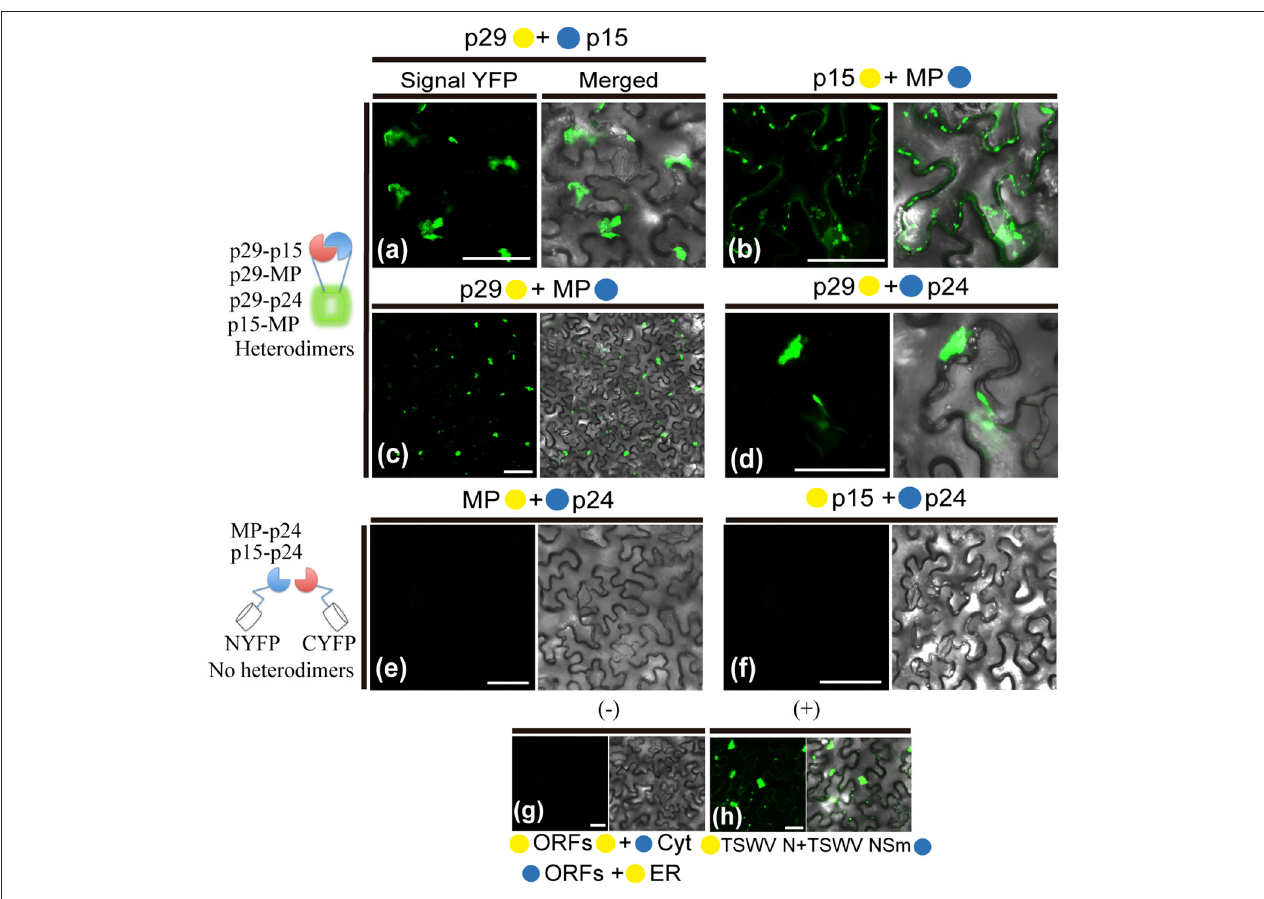
FIGURE 8 | BiFC analyses of heterodimerization between proteins of Citrus leprosis virus C. p29, p15, MP, and p24 carrying N-terminal (•) or C-terminal (•) YFP fragments fused at their N- ( •/•–ORFs) or C-termini (ORFs-•/•) were transiently co-expressed in N. benthamiana leaves by agroinfiltration. Representative protein pair combinations are indicated at the top of each image; all hetero-combinations performed are shown in Table 2 . (a–d) Correspond to positive interactions (heterodimers: p29-p15, p29-MP, p29-p24, and p15-MP), summarized in the scheme to the left of the images. (e,f) Correspond to non-interaction (no heterodimers: MP-p24 and p15-p24) also summarized in the scheme. Negative controls correspond to the expression of the CiLV-C proteins in combination with Cyt or ER BiFC vectors (g) . Positive control corresponds to the expression of the N and NSm proteins of the TSWV in BiFC construction, which is known to interact in vivo (h) . Bars correspond to 50 µ